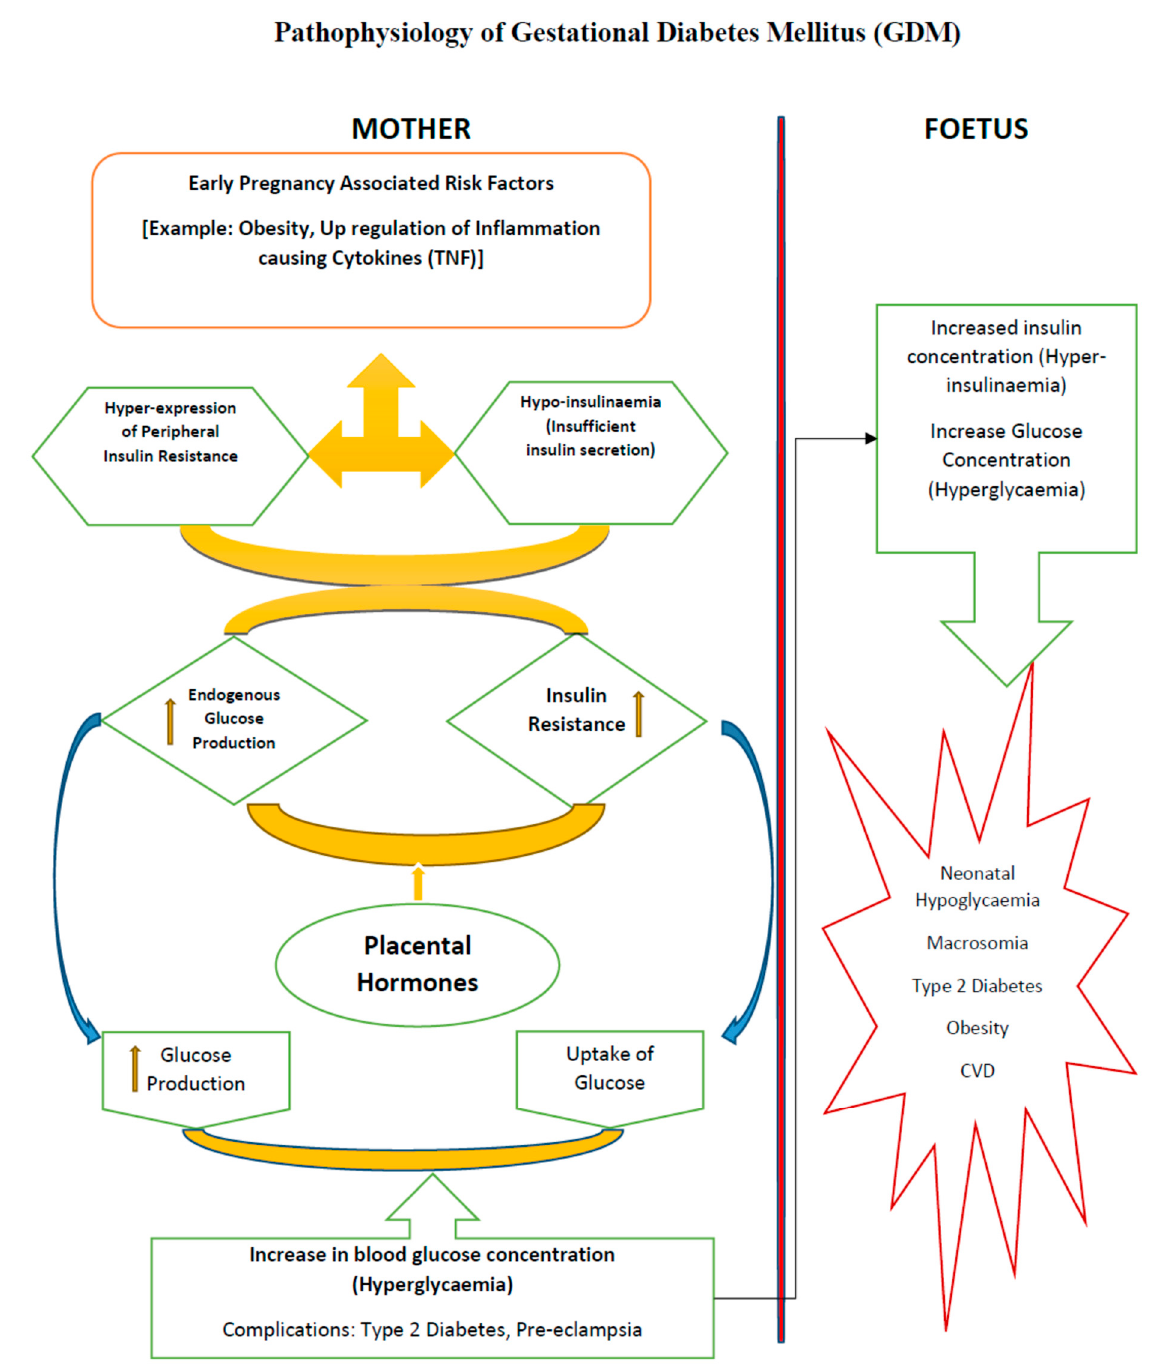
Figure 1. Physiological phenomena in Gestational Diabetes Mellitus (GDM). It has been evidenced experimentally that GDM affects women with dysfunctional metabolic systems before conception. During pregnancy, under hyperglycaemic overload and increased β -cell demand to compensate glucose uptake, endogenous insulin becomes unresponsive or undergoes increased insulin resistance, and is thereby unable to perform cellular glucose uptake through peripheral skeletal muscles and adipose tissue. The defects in the β -cell subsequently leads to insulin resistance in the maternal system, which leads to complications, such as hyperglycaemia and hyperinsulinemia, and may result in short term metabolic problems, such as foetal overgrowth or macrosomia, and long-term problems, including obesity and T2D.